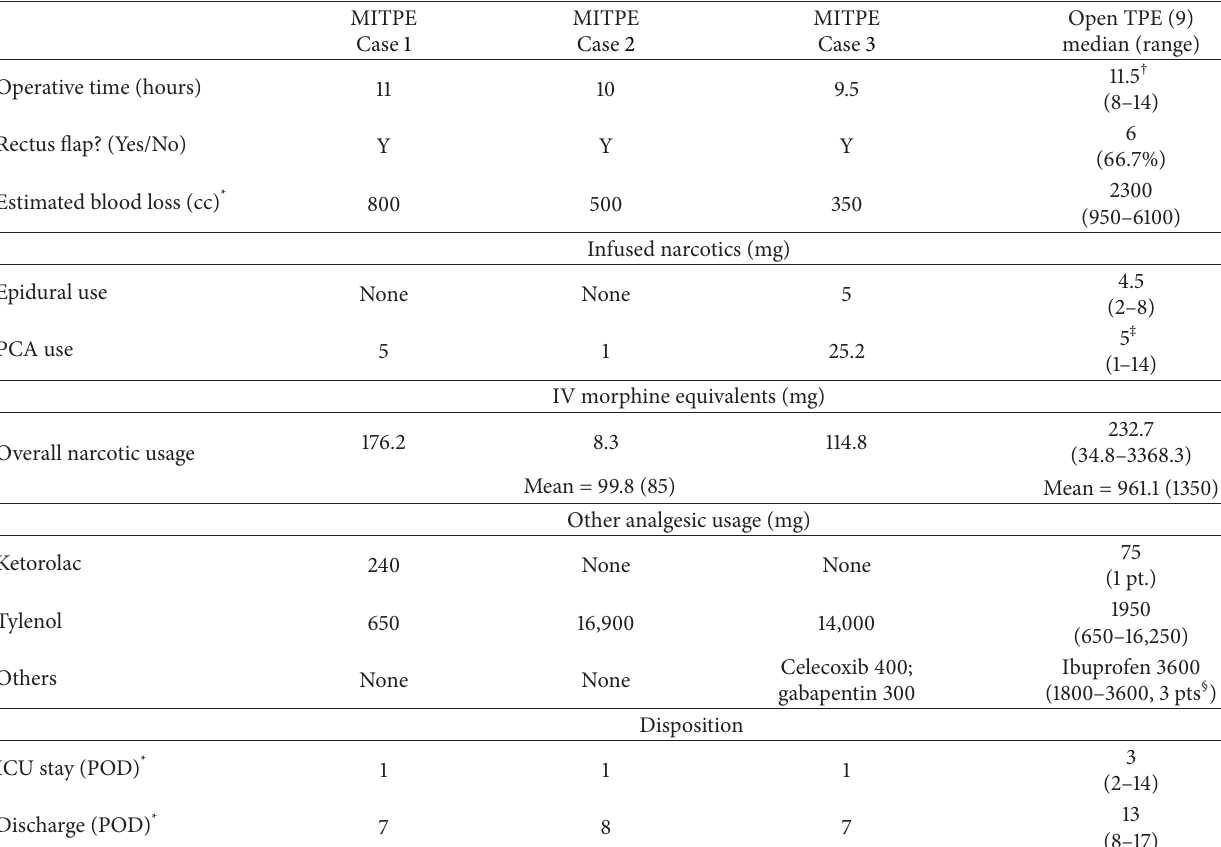
Table 2: Operative characteristics and hospital course of robotic total pelvic exenteration with laparoscopic rectus flap (MITPE) versus open patients.